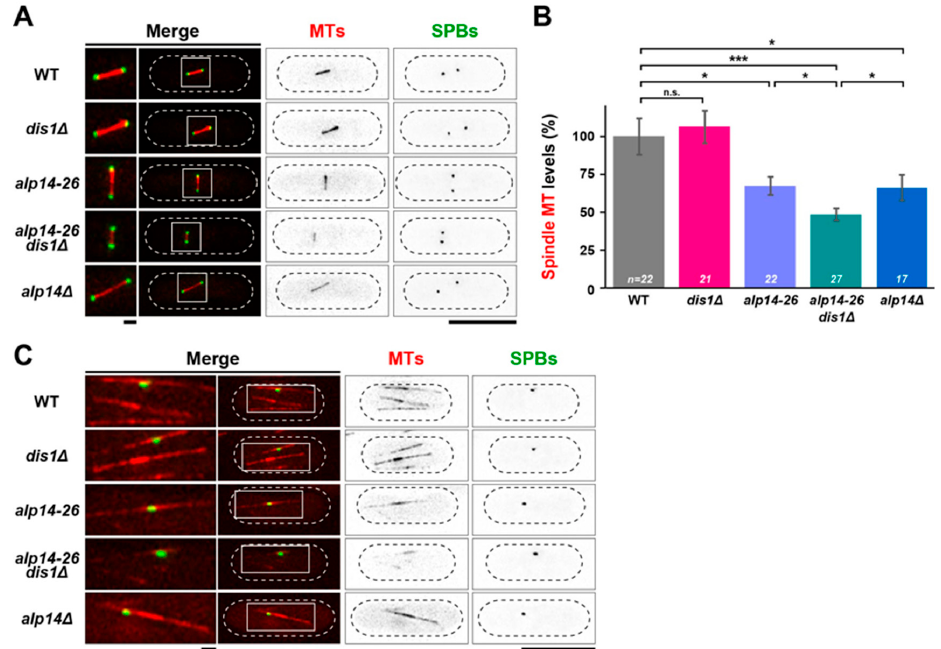
Figure 3. Microtubule intensities are reduced in alp14-26dis1 ∆ in an additive fashion compared to each single mutant. Exponentially growing cells at 27 °C were shifted to 36 °C for 2 h. Spindle MTs (mCherry-Atb2; red) and SPBs (Cut12-GFP; green) were visualised. ( A ) Representative images of mitotic spindles. Cell peripheries are indicated by dotted lines and areas containing spindle MTs (squares) are enlarged in the left-hand side panels. ( B ) Quantification of spindle MT intensities. Fluorescence intensities of mCherry-Atb2 were measured in the indicated strains. The values of wild-type cells were taken as 100% and used for comparison to other strains. All p -values were obtained from a two-tailed unpaired Student’s t test. Data are presented as the means ± SEM ( ≥ 17 cells). (* p < 0.05; *** p < 0.001; n.s., not significant.) ( C ) Representative images of interphase MTs. Images were taken from samples incubated at 27 °C. Cell peripheries are indicated by dotted lines and areas containing interphase MTs (squares) are enlarged in the left-hand side panels. Scale bars, 1 µm (left) and 10 µm (right).